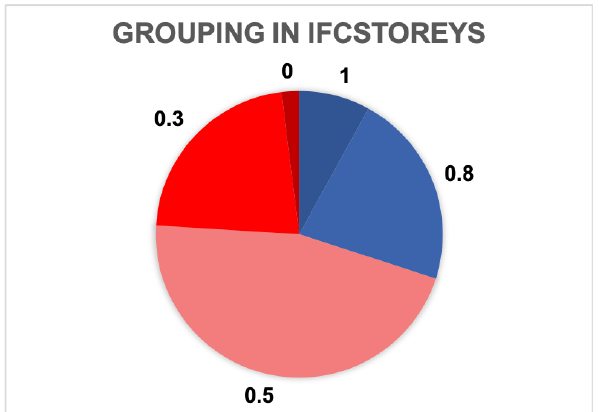
Figure 6. Distribution of models according to the assigned scores about the quality of grouping in